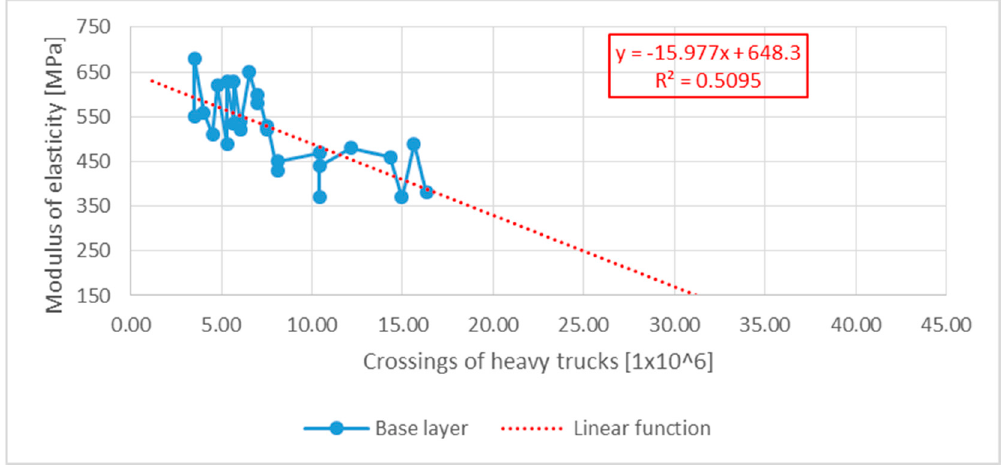
Figure 15. Modulus of elasticity forecast of road foundation.